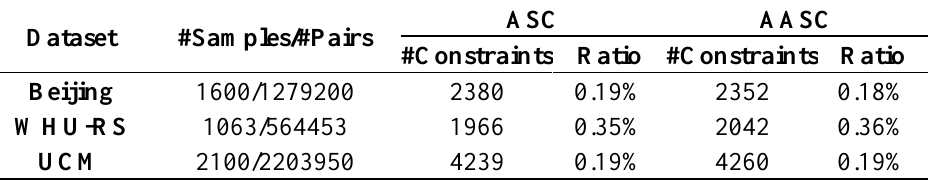
Table 1. Final numbers of constraints for ASC and